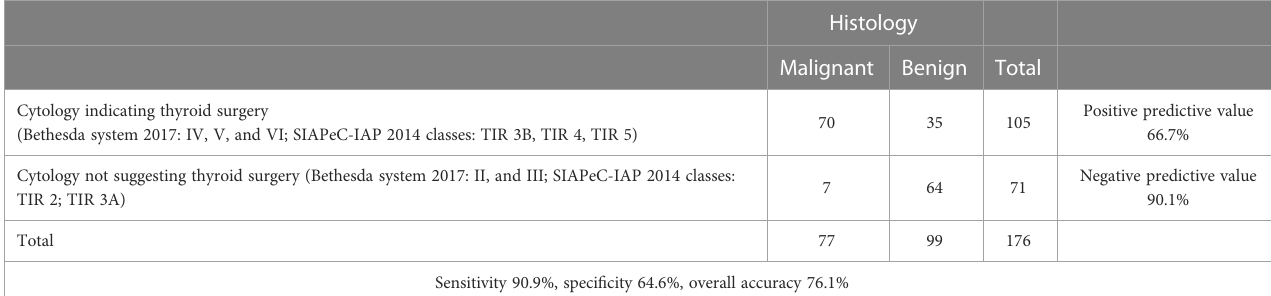
TABLE 3 Assessment of cytological consistency in supporting clinical decisions according to guidelines (n = 176, TIR 1 – Bethesda class I